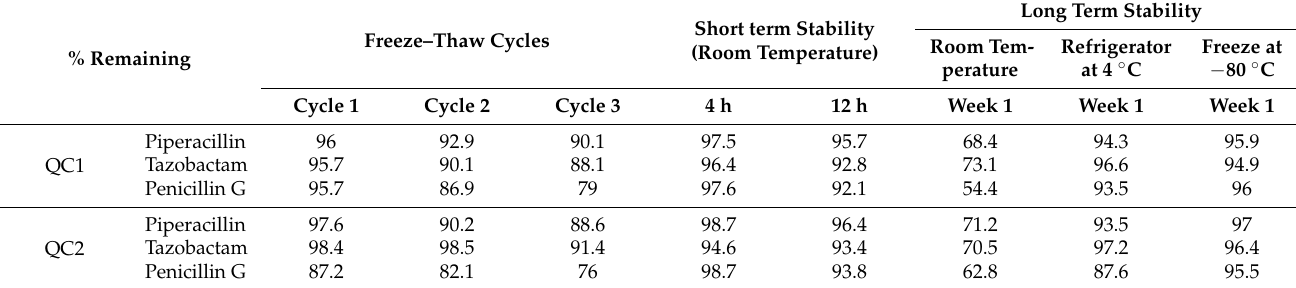
Table 3. Stability of piperacillin, tazobactam and penicillin